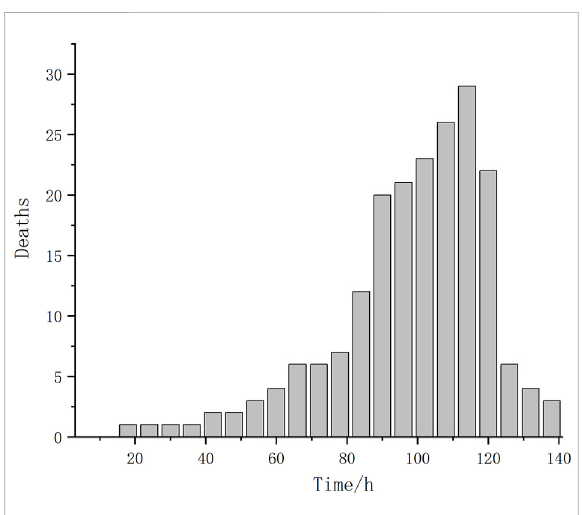
FIGURE 1 The deathnumbersof shrimp indifferenttime after ammonia nitrogen